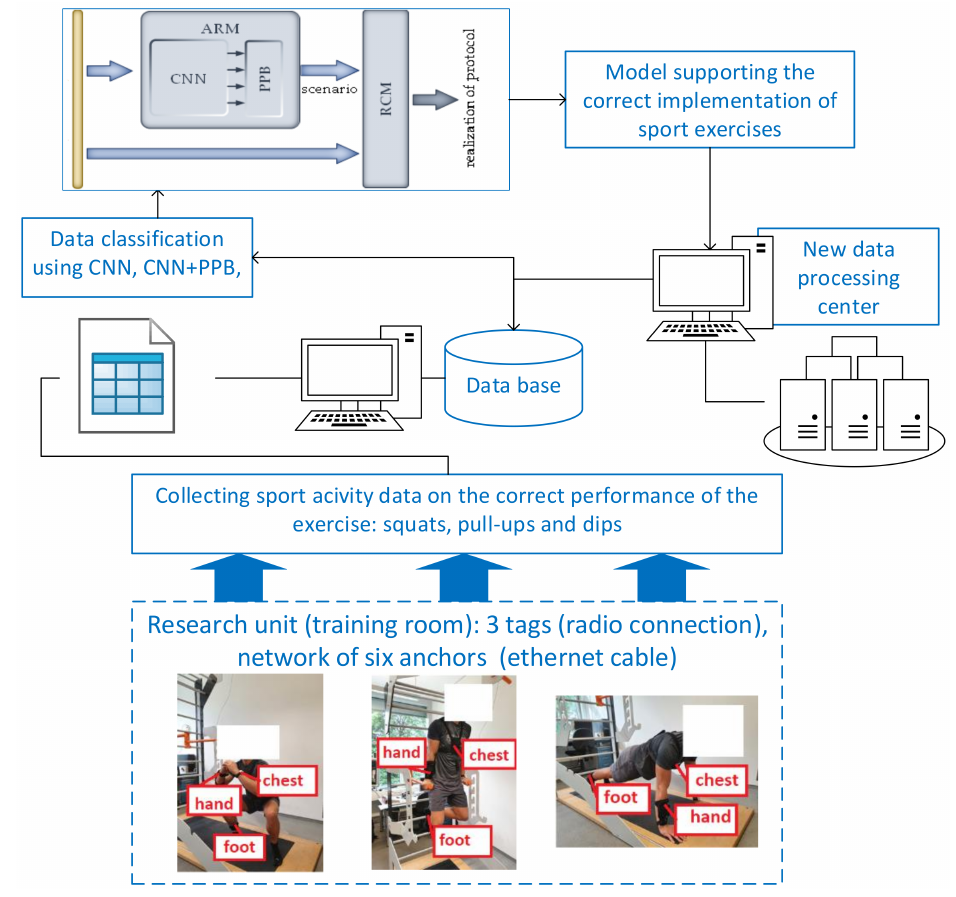
Figure 1. Schematic representation of the advisory system supporting the correct implementation of sport exercises, namely squats, pull‑ups and